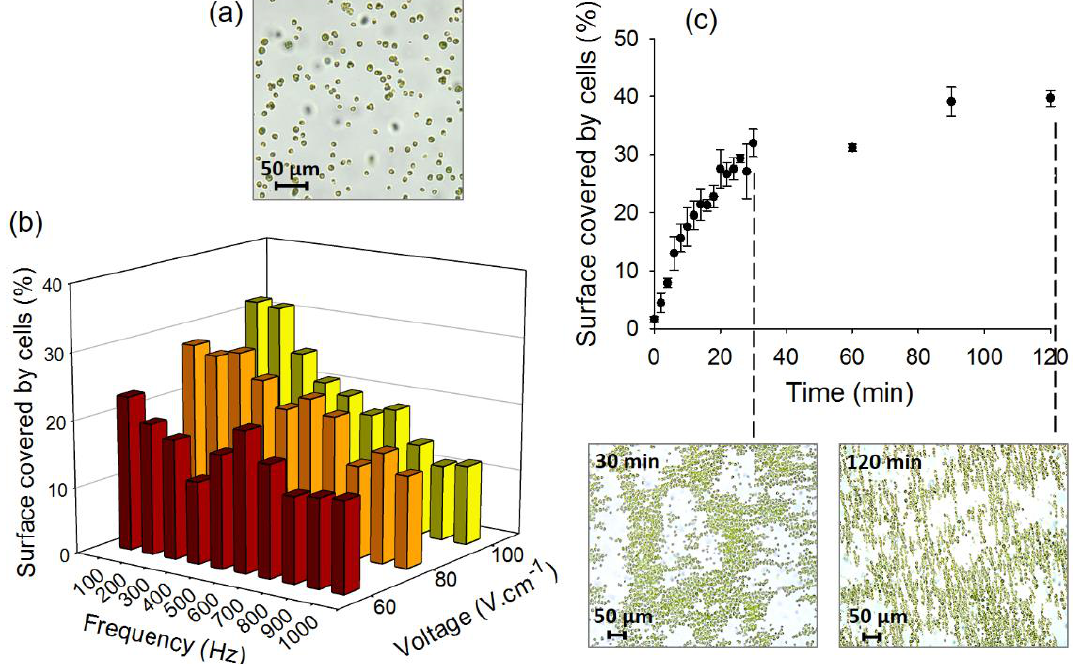
Figure 2. ( a ) Bright-field image of the algal cell suspensions in the microfluidic chamber with no AC-field applied; ( b ) Effect of field intensity and frequency; and ( c ) duration on the percentage of the surface of the chamber covered by cells. The bright-field images represent the 2D-assembly of C. reinhardtii obtained at combination of 100 V·cm − 1 , 100 Hz after 30 and 120 min duration using four-point stainless steel needle electrodes. Initial concentration of algae in suspensions: 5 × 10 6 cells·mL − 1